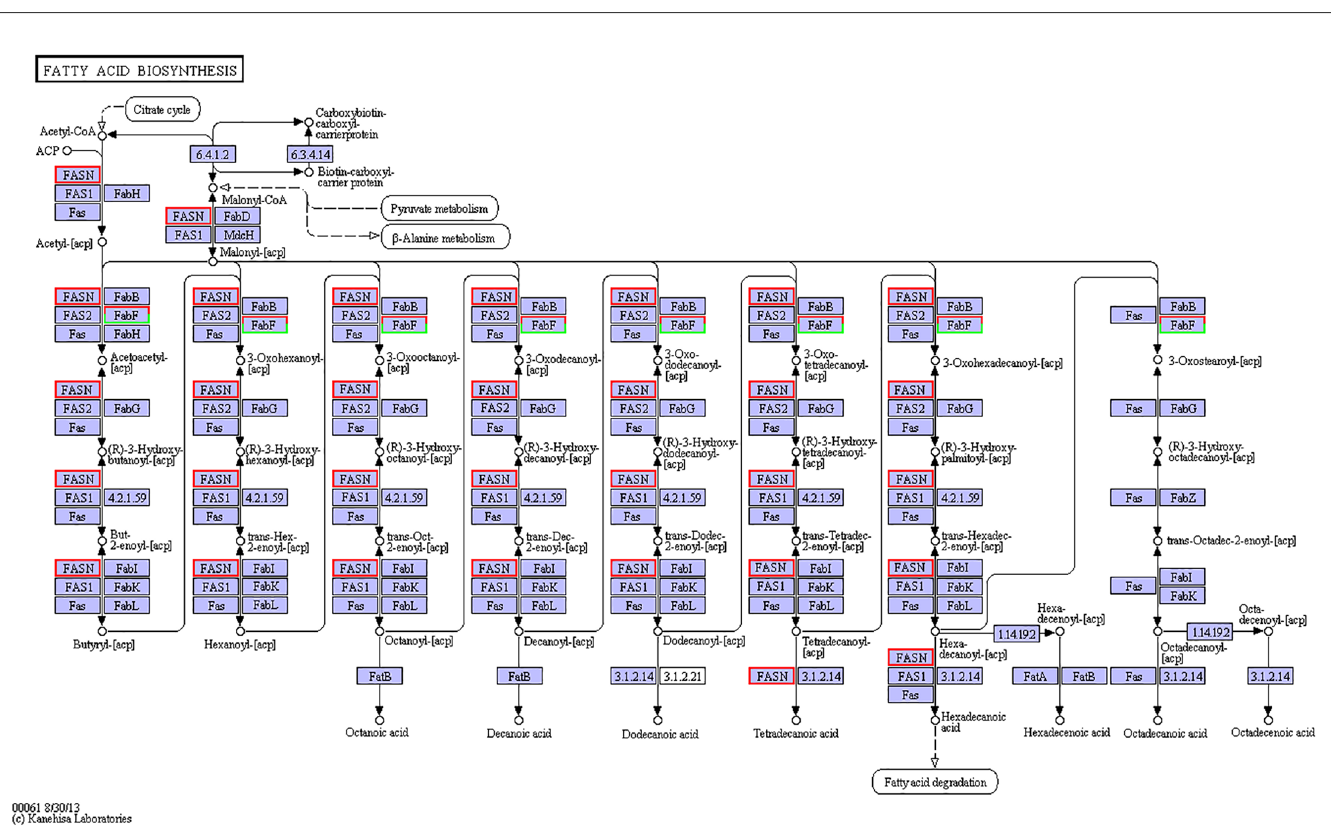
Fig 3. Pathways of fatty-acid biosynthesis (ko00061). The red frames represent the genes were up-regulated, while the green frames represent that the genes were down-regulated. The frames with both red and green indicate that these genes have more than one unigenes, and some of them were up- regulated, but others were